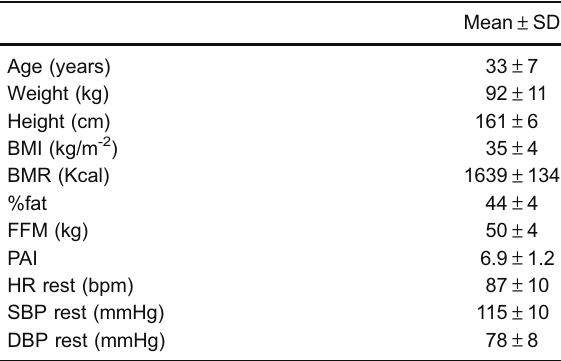
Table 1. Subject characteristics